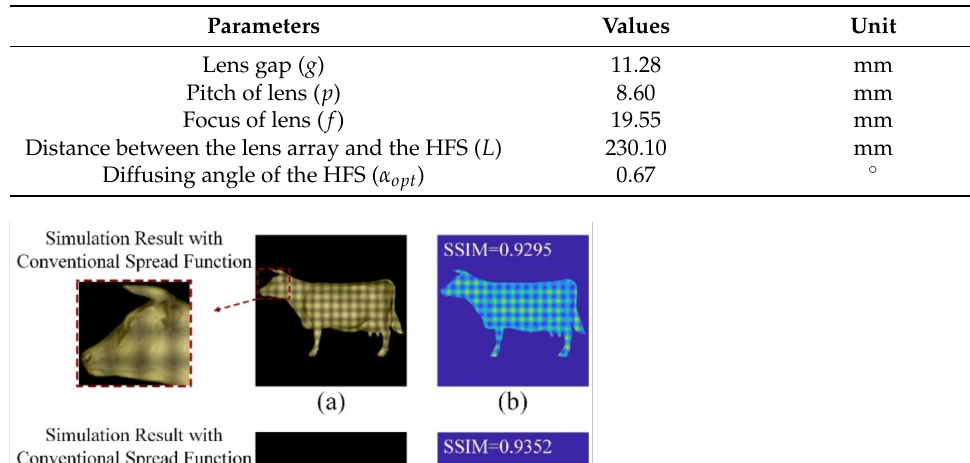
Table 1. The main parameters of the simulated 3D LFD system configurations.